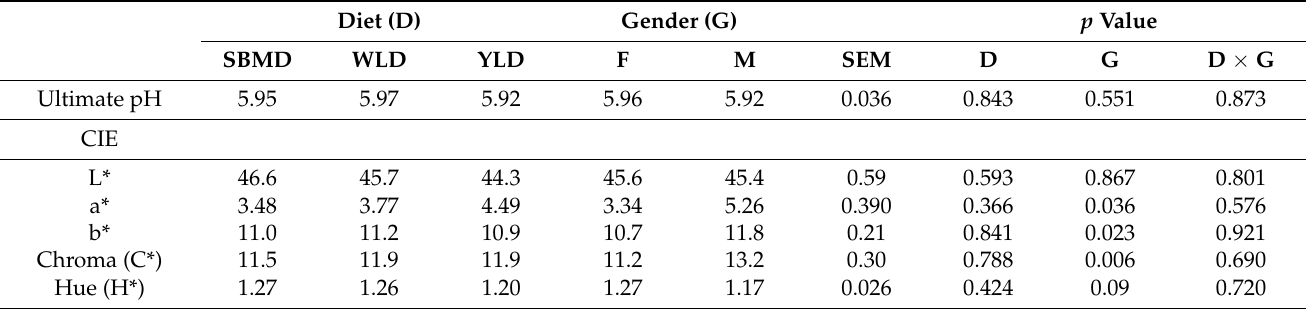
Table 3. Effects of diet and gender on the meat physical characteristics of the longissimus dorsi muscle of rabbits ( n = 10 per